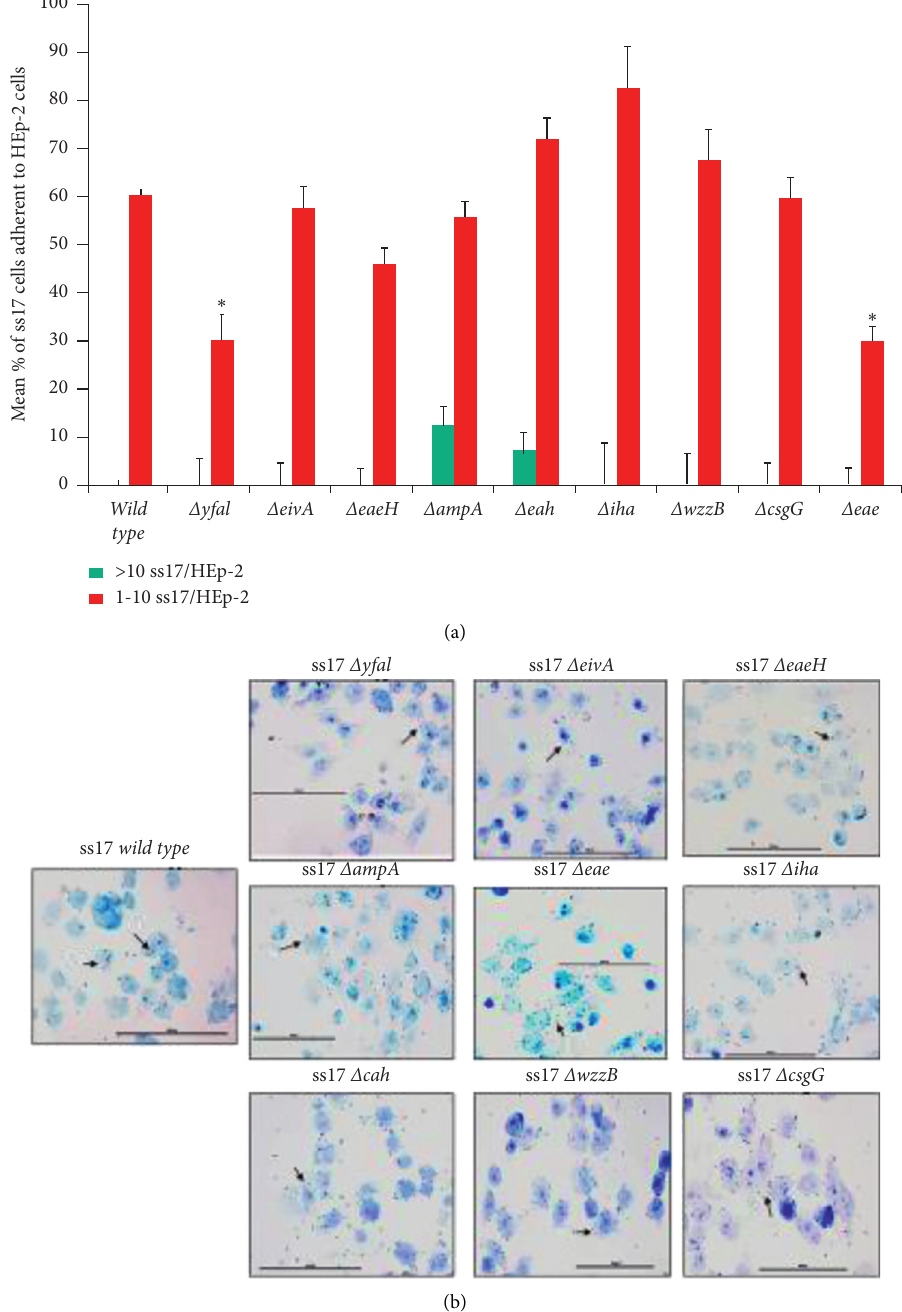
Figure 4: SS17 adherence mutant phenotypes on HEp-2 cells. Adherence of the parental strain and subsequent adherence-associated gene mutants of SS17 were tested for adherence quantitatively (a) and qualitatively (b). As the results show, SS17 Δ yfal , Δ eaeH , and Δ eae are all deficient in adhering to HEp-2 cells compared to the parent SS17 strain. (a) Each bar is representative of four technical replicates per slide where 20 cells/spot were counted over two trials. The bar is the mean percentage of adherent bacteria ( > 10 or 1–10) per HEp-2 cell over the two trials. (b) Toluidine blue-stained slides are used to see the “adherence morphology” of SS17 to HEp-2 cells. The scale bar for each panel is set to 100 μ m. Asterisks denote p value <